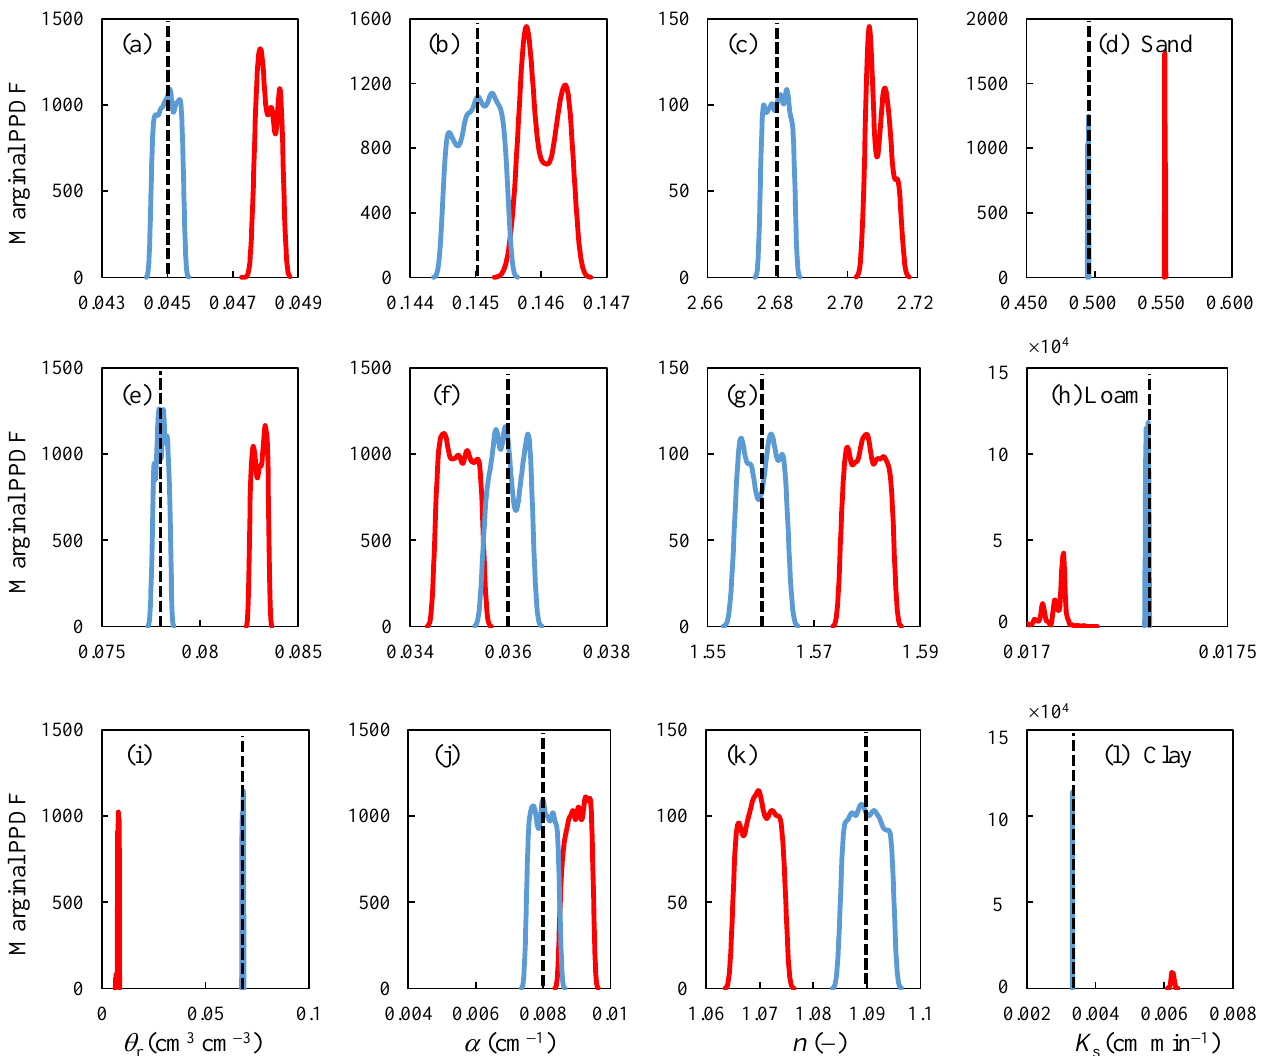
Figure 3. The marginal posterior probability density functions (PPDF) of the parameters obtained from inverse modeling for the synthetic examples: ( a – d ) sand example, ( e – h ) loam example and ( i – l ) clay example. The red and blue curves were extracted from the SO and MO approaches, respectively, whereas the vertical dashed line denotes the exact